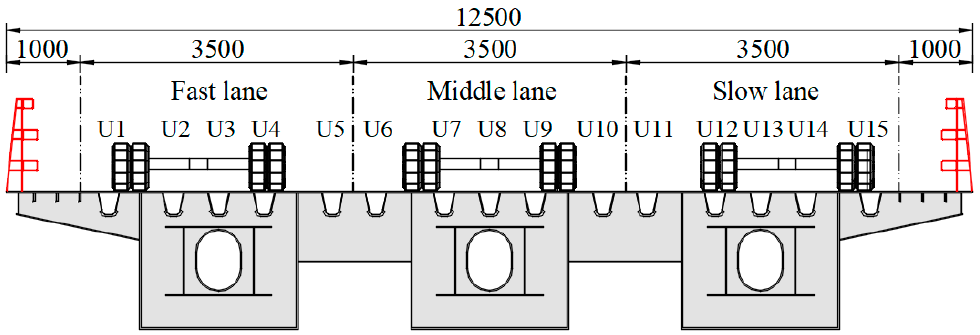
Figure 4. Sectional view of the prototype bridge (Unit: mm).